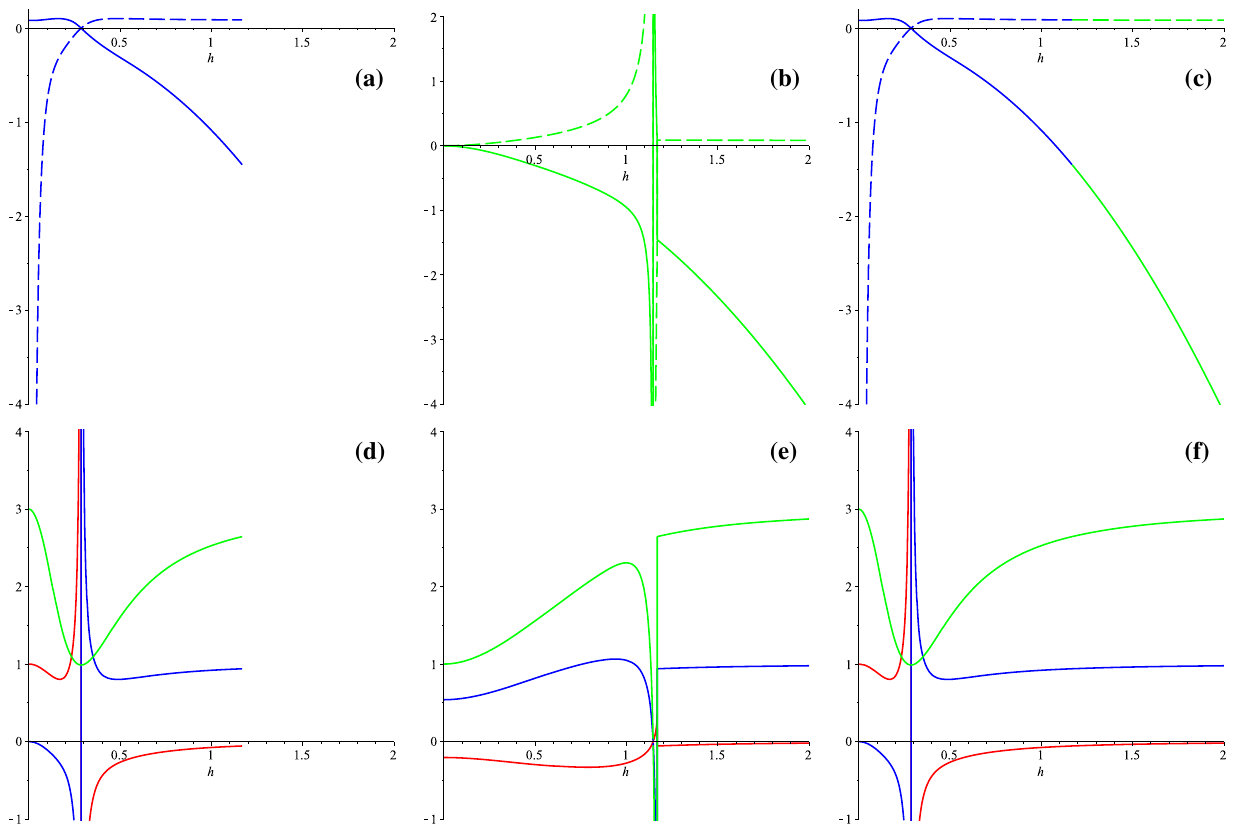
Fig. 6 The dynamics for α < 0, β < 0 restored from gluing differ- ent branches: the case of ( ˙ H ( h ), ˙ h ( h )) on a – c panels and the case of Kasner exponents ( p H , p h ) on d – f panels. On a panel we presented ( ˙ H ( h ), ˙ h ( h )) for H 2 branch, on b – for H 3 branch while in c – real physical evolution recovered from gluing proper parts of H 2 and H 3